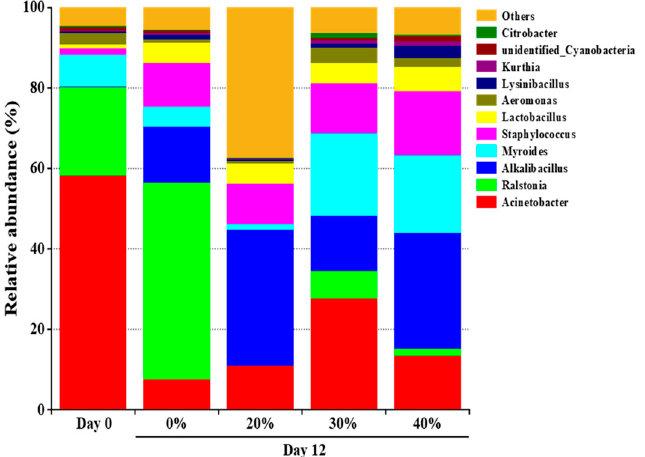
Figure 1. The relative abundance of dominant bacteria at the genus of traditional dry sausage with different KCl substitution ratios at day 0 and day 12. 0%: control dry sausage (2.50% NaCl); 20%: dry sausage with 20% KCl substituted for NaCl (2.00% NaCl + 0.50% KCl); 30%: dry sausage with 30% KCl substitution (1.75% NaCl + 0.75% KCl); 40%: dry sausage with 40% KCl substitution (1.50% NaCl +1.00% KCl).